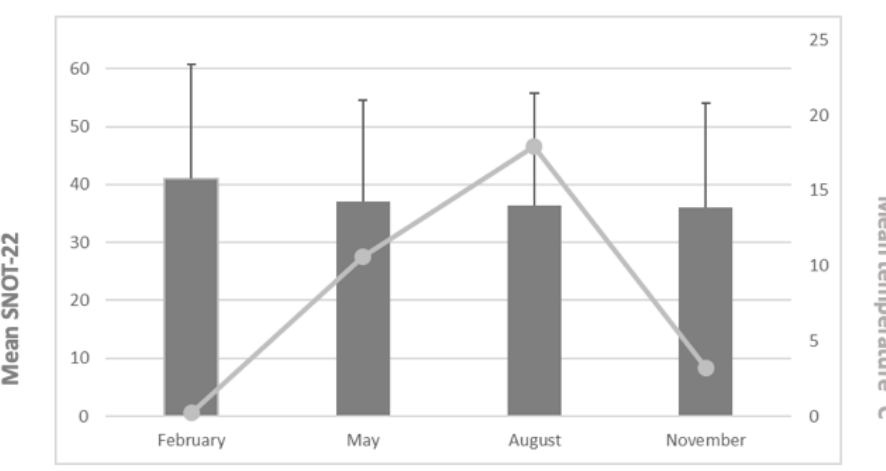
Figure 4. Mean SNOT-22 values (and SD values) and mean temperatures for the study periods.